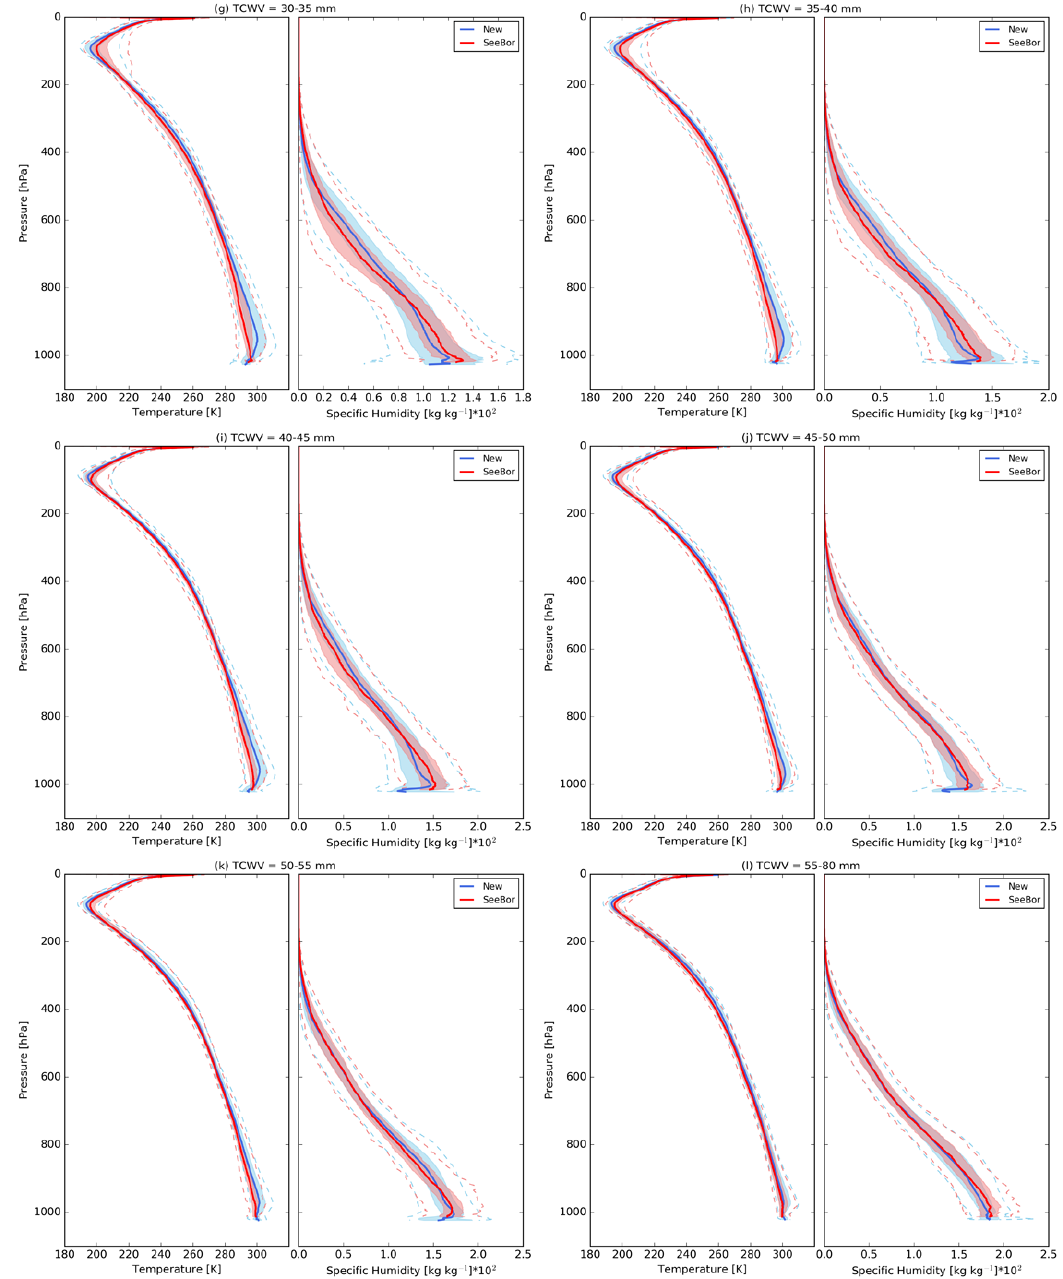
Figure 4. Distribution of the temperature ( left ) and specific humidity ( right ) profiles selected for the calibration database (blue) for each TCWV class (( a ) 0–5 mm; ( b ) 5–10 mm; ( c ) 10–15 mm; ( d ) 15– 20 mm; ( e ) 20–25 mm; ( f ) 25–30 mm; ( g ) 30–35 mm; ( h ) 35–40 mm; ( i ) 40–45 mm; ( j ) 45–50 mm; ( k ) 50–55 mm; ( l ) 55–80 mm). The solid lines represent the median, the shaded areas represent the 25th to 75th percentiles, and dashed lines represent the 5th and 95th percentiles. The distribution of the SeeBor profiles is also shown for reference (in